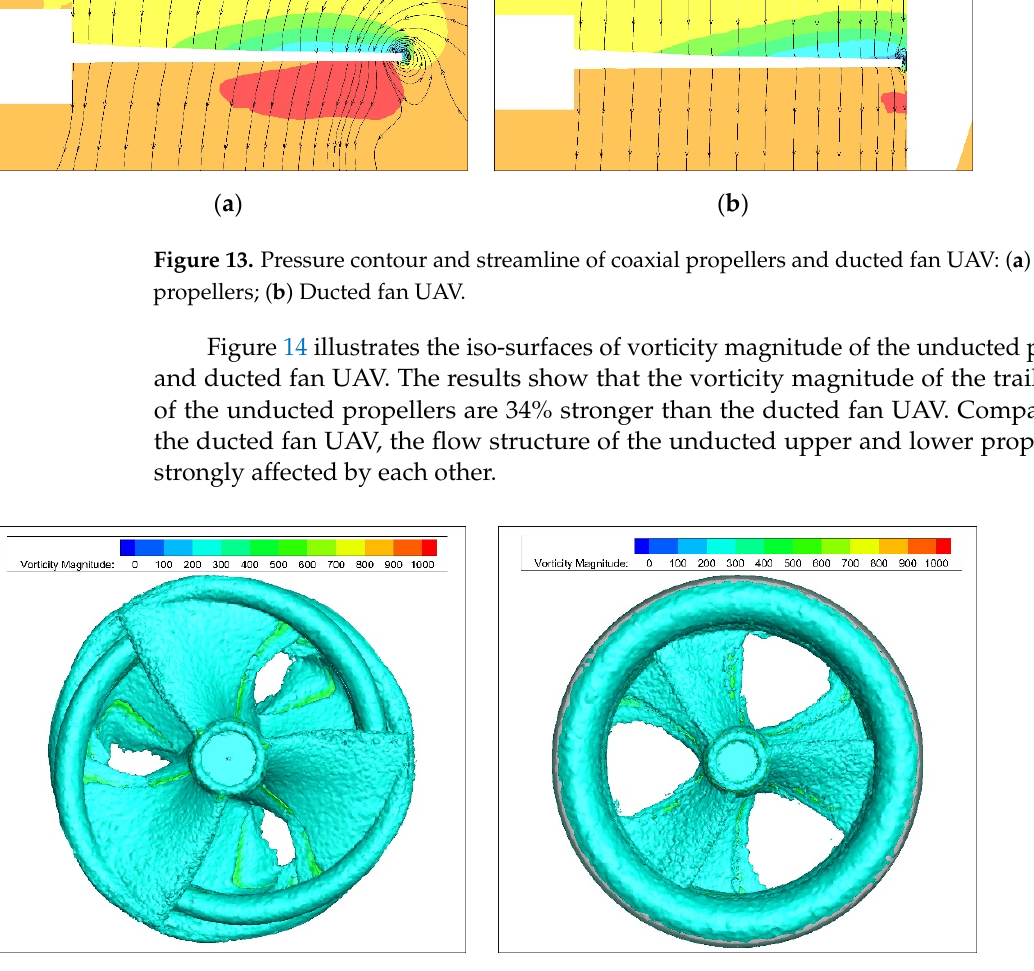
Figure 14. Vorticity magnitude Iso-surfaces of unducted propellers and ducted fan UAV: ( a ) Unducted propellers; ( b ) Ducted fan UAV.